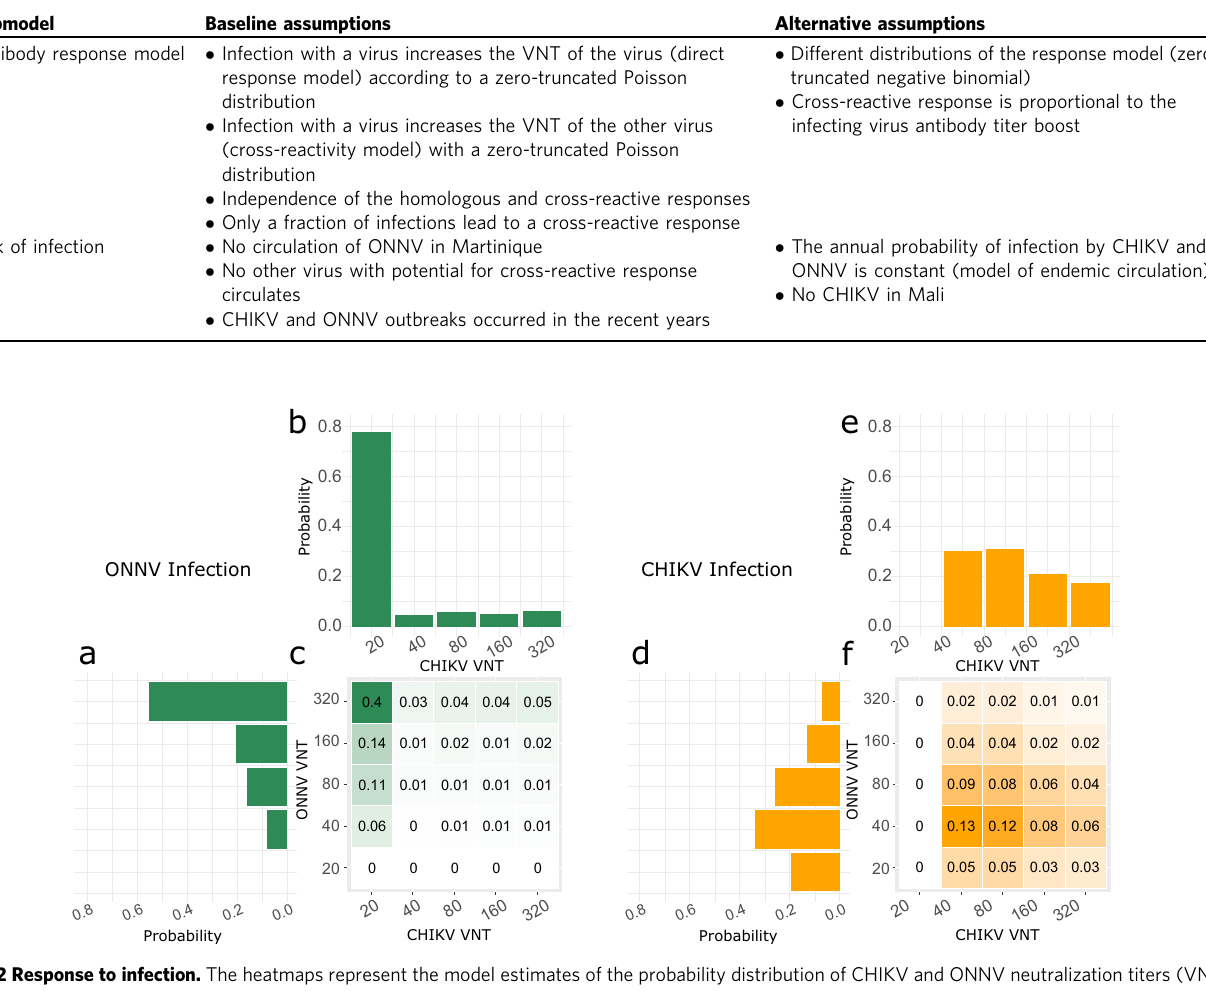
Table 2 Summary of the assumptions of the antibody response model and in the model of virus circulation. Alternative assumptions are tested in additional sensitivity analysis. VNT: Virus neutralization titer.